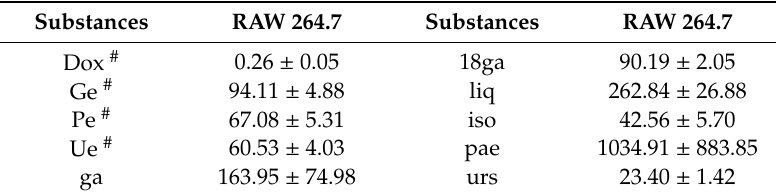
Table 2. Cytotoxicity (IC 50 values *) of individual plant extracts and PSMs in RAW264.7 cells. Substances RAW 264.7 Substances RAW 264.7 0.26 ± 0.05